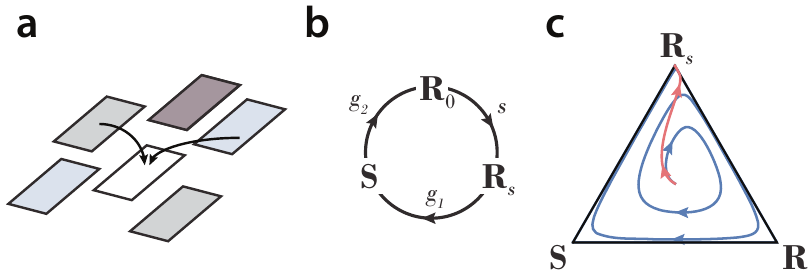
Fig. 6 Patch invasion dynamics and evolutionary stability. ( a ) The patch invasion model considers co-invasion events into a cleared patch. Patch clearing events occur at rate c . Shading re fl ects different patch types. ( b ) Illustration of the rock-paper-scissors-type dynamics among a resistance switching strain R s (which carries phage), a non-switching strain R 0 , and a sensitive strain S . R 0 beats R s with rate s , R s beats S with rate g 1 , and S beats R 0 with rate g 2 . ( c ) Patch invasion game dynamics approaches a heteroclinic cycle on the boundary for s > c (blue curve) or the evolutionarily stable strategy R s for s < c (pink curve).